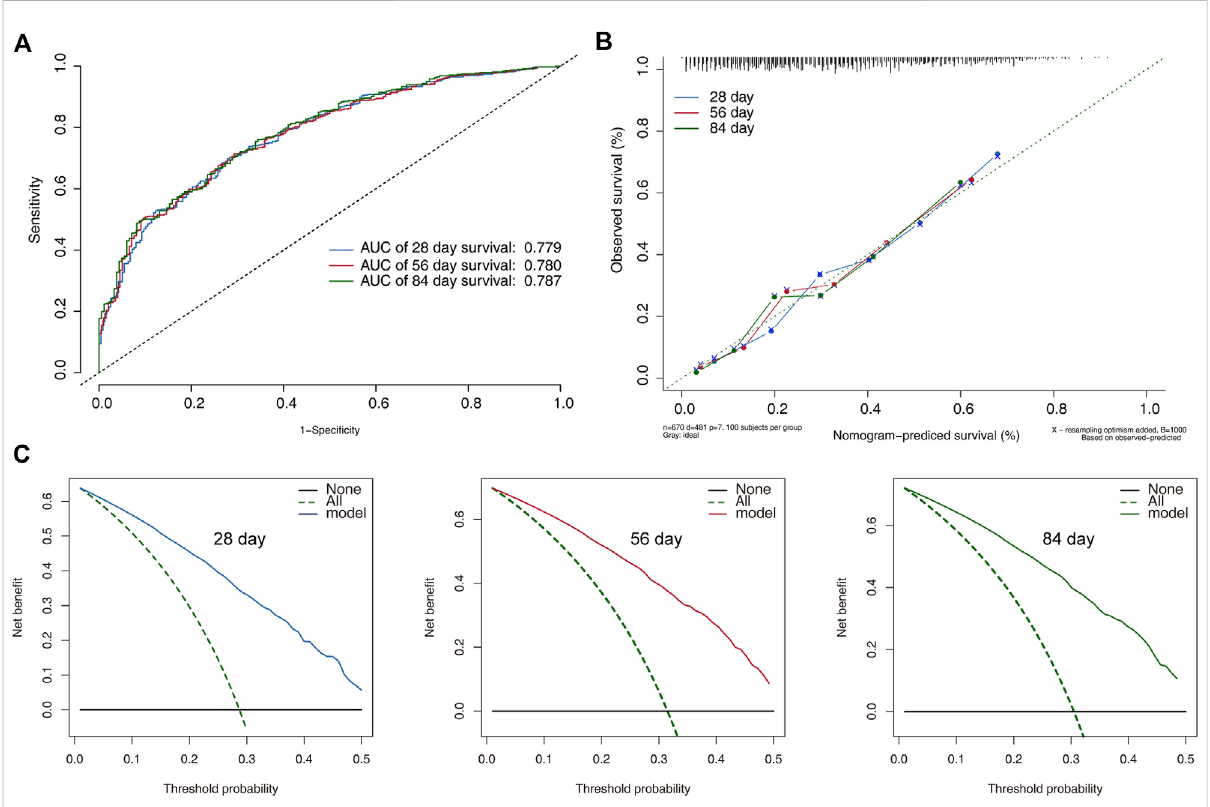
FIGURE 4 Model performance and discrimination in the training set. (A) Receiver operating characteristic curves for model-based prediction of overall survival. (B) Calibrationcurvesforthemonograminthecohort,wherethe x and y axesshowtheprojectedprobabilityandtheobservedprobabilityof all-cause mortality. (C) The decision curve analysis of the training cohort ’ s 28-, 56-, and 84-day survival nomogram. The area between the “ no treatment line ” (black line) and the “ all treatment line ” (light gray line) on the model ’ s curve represents its clinical